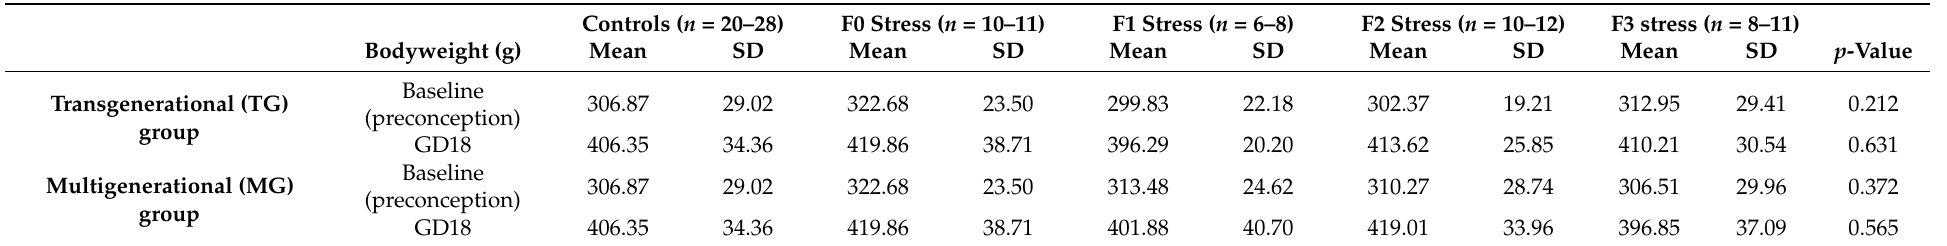
Table 2. Preconceptional and gestational SIS did not affect maternal weight at baseline or during